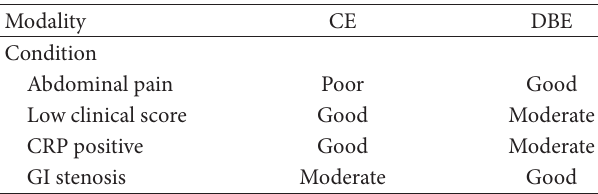
Table 9: Indications of CE and